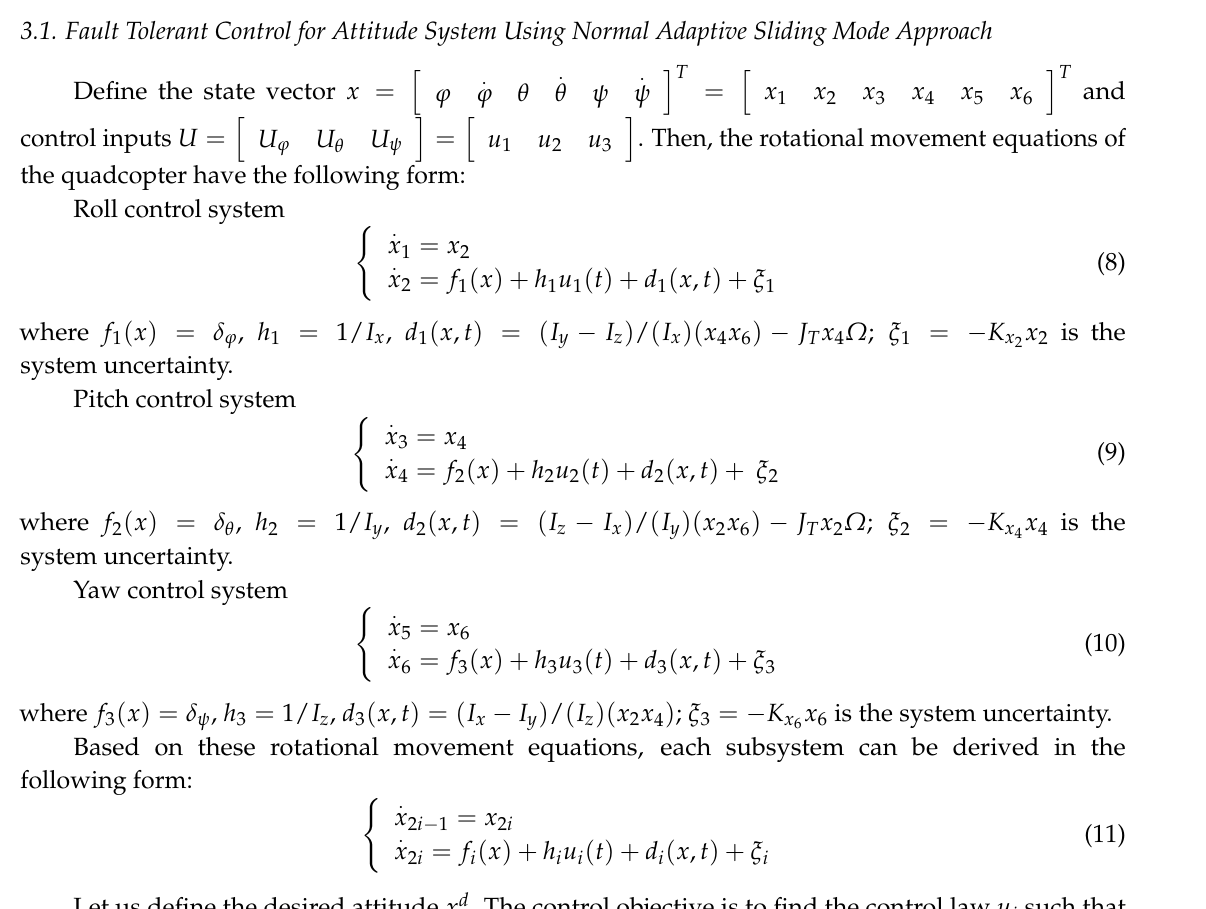
Figure 2. Control scheme of the quadcopter.